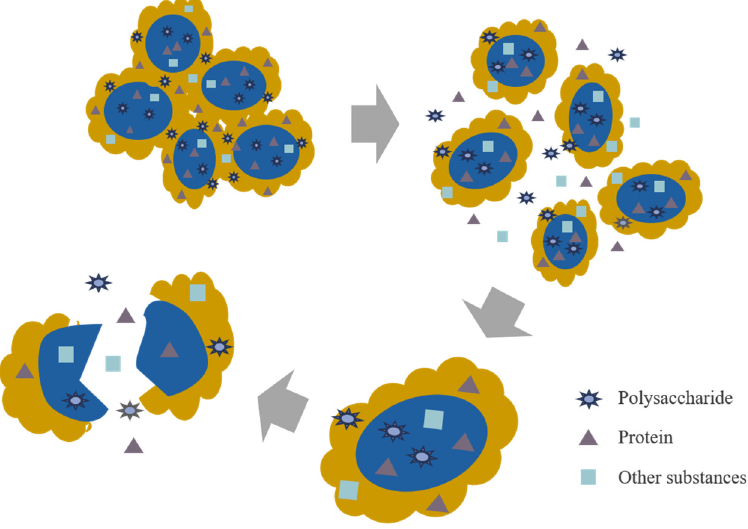
Figure 7. Schematic diagram of the electrochemical cell lysis process.